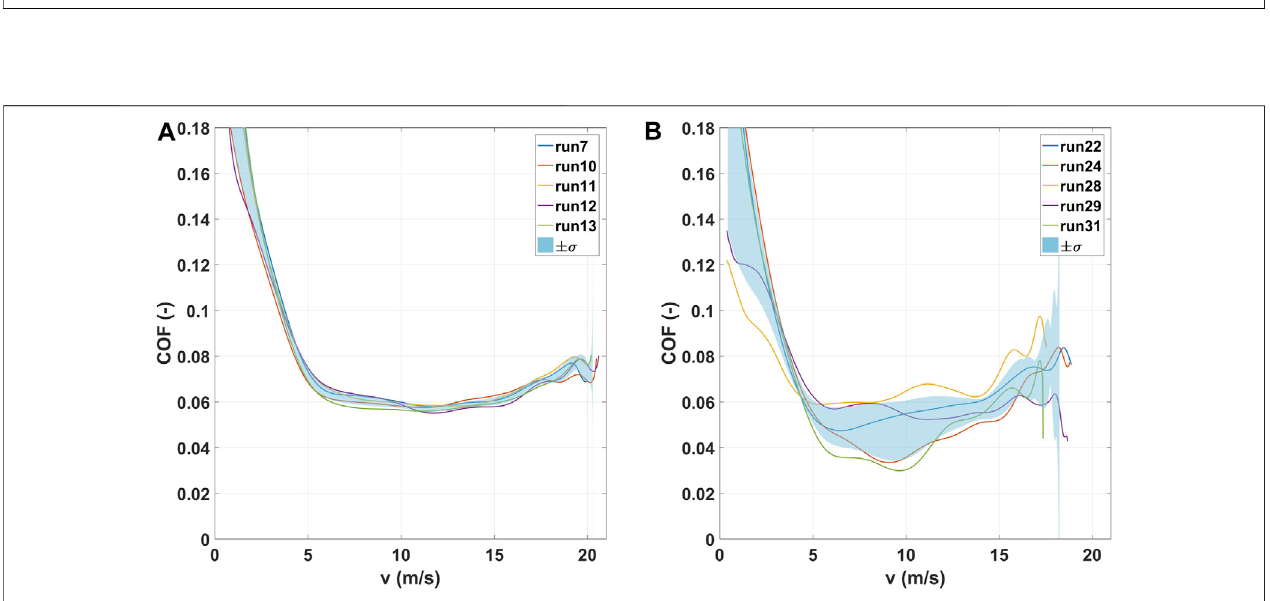
FIGURE 9 | (A) Five consecutive runs of skier S1 on February 13, on cold winter snow with calm air (v wind (cid:1) 0.1 ± 0.7 m s − 1 , COF (cid:1) 0.059 ± 0.001). (B) Five consecutive runs of skier S4 on March 4, on warm winter snow with a light breeze (v wind (cid:1) 2.2 ± 1.1 m s − 1 , COF (cid:1) 0.054 ± 0.006).